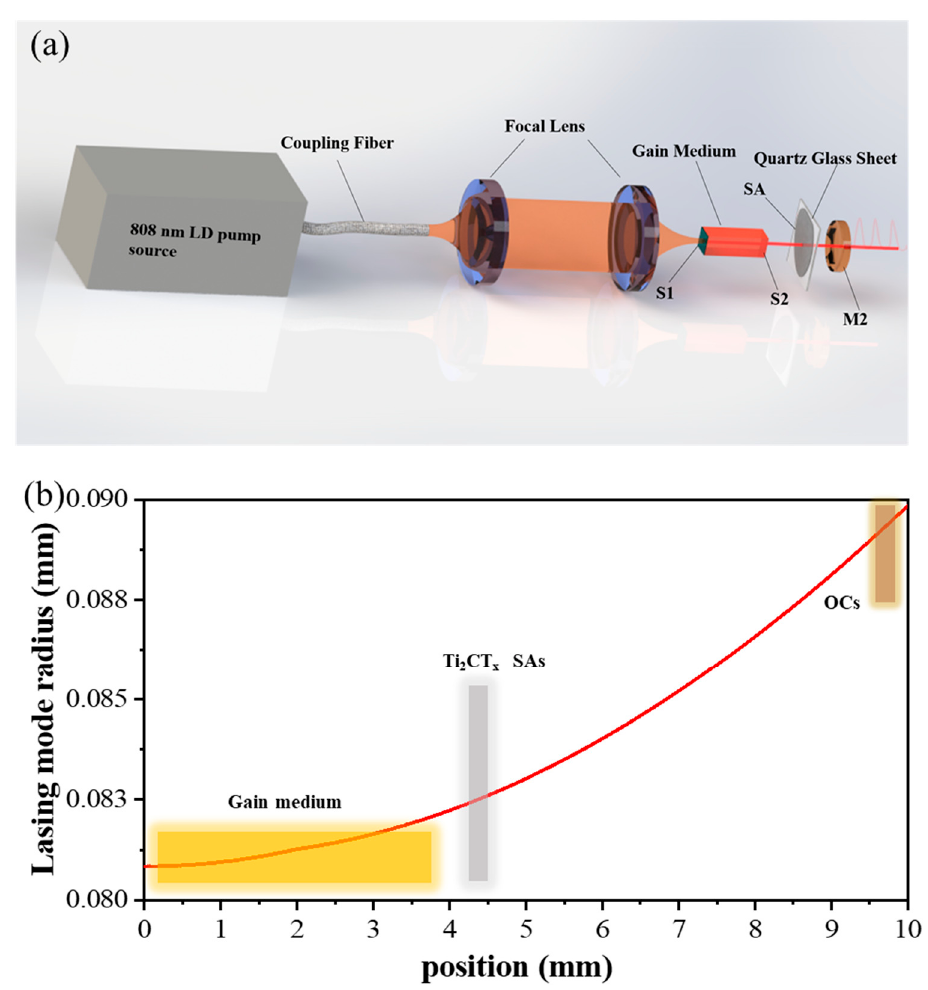
Figure 4. ( a ) Experimental setup for the MXeneTi 2 CT x -SAs based passively Q-switched laser. ( b ) The lasing mode radius of the spot in the laser cavity by theoretical estimation.